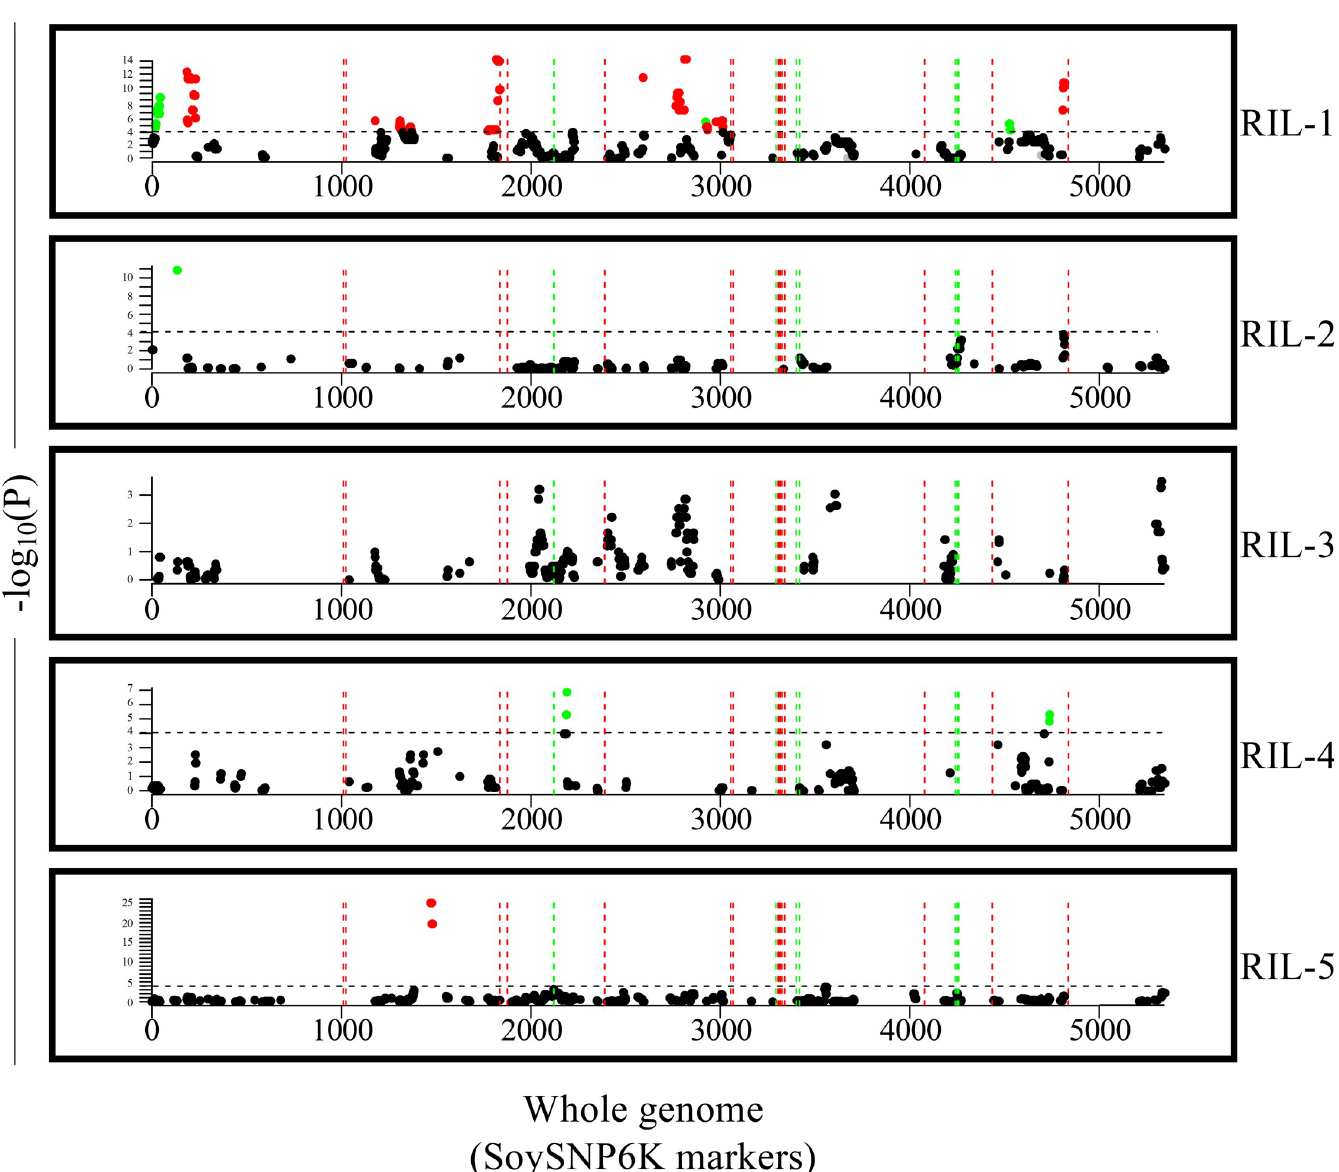
Fig 2. Genomic regions from PI 416937 under positive (green) and negative (red) selection within RIL populations at whole-genome level. The x-axis displays marker positions from SoySNP6K Infinium BeadChips. The statistical threshold was set for each population based on an LD adjusted multiple test correction. Gray indicates a locus had less than 10 trios testing a PI 416937 allele against an alternative allele. Black indicates a locus had 10 trios or more but fell below our significance threshold. Vertical dashed lines indicate regions identified under breeding selection from the original pedigree analysis performed on high yielding lines derived from PI